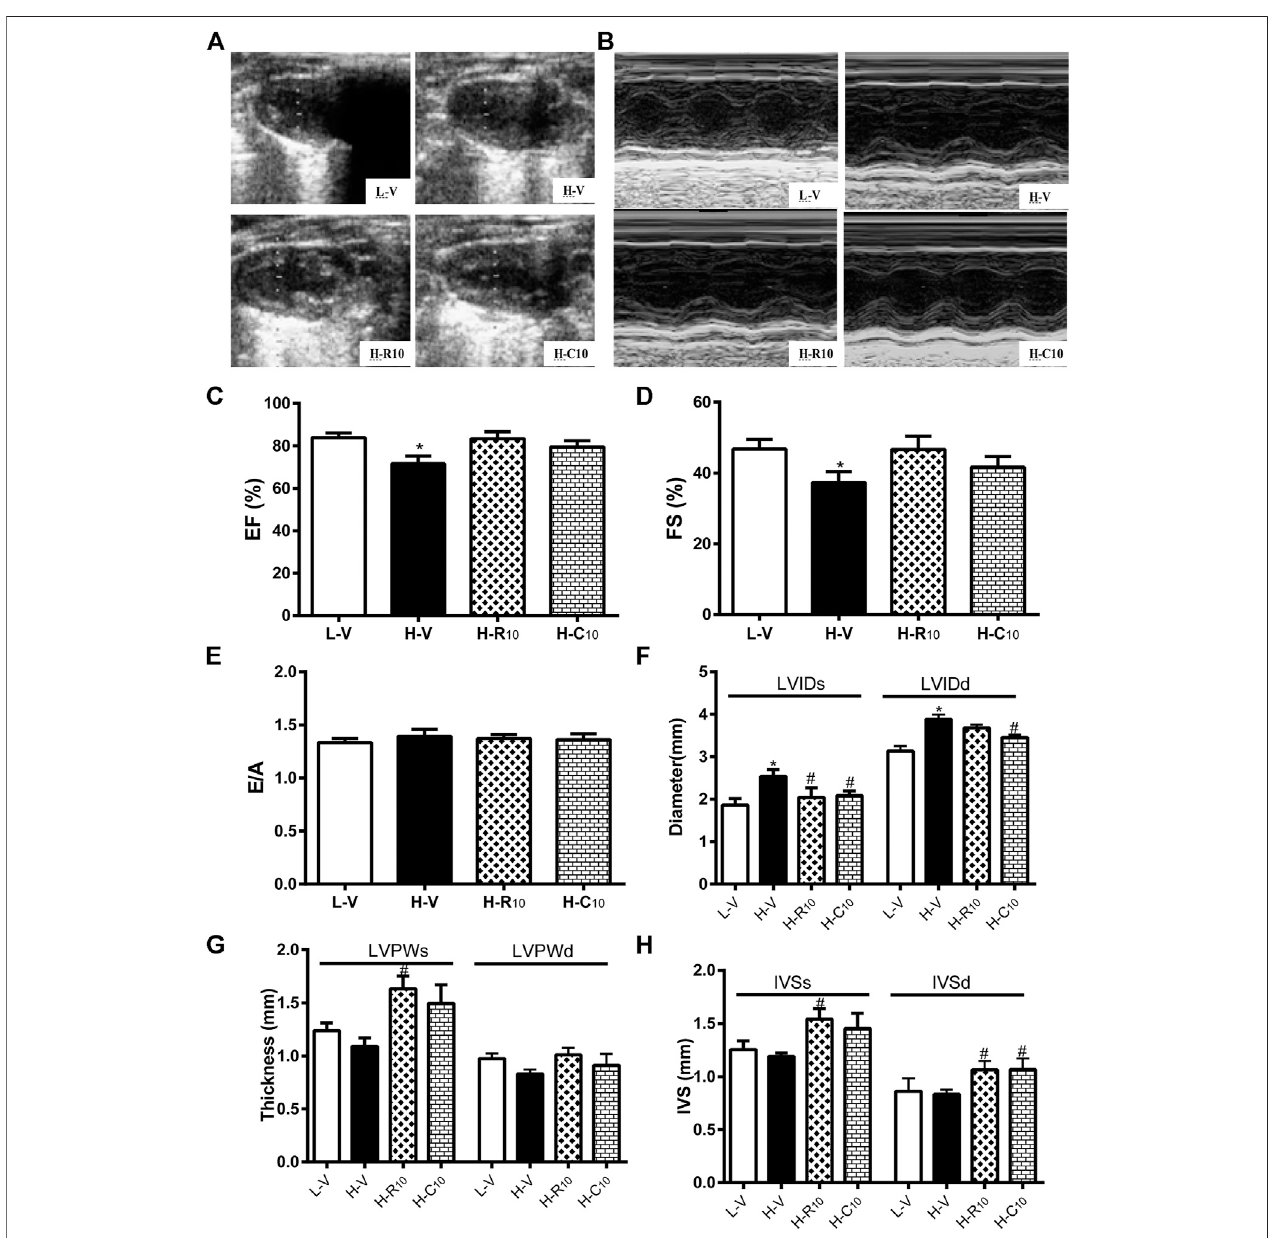
FIGURE 4 | Rosiglitazone and CMHX008 ameliorate HFD-induced myocardial function but have different effects on echocardiographical indexes. (A) Representative 2D echocardiograph and, (B) M-mode image of mice treated with CMHX008, rosiglitazone or vehicle; (C) Quanti fi cation of ejection fraction (EF), (D) fractional shortening (FS), and (E) the ratio of E to A velocity (E/A); (F) Measurements of the left ventricle internal diameters in systole (LVIDs) and diastole (LVIDd), (G) left ventriclewallthicknessinsystole(LVPWs)anddiastole(LVPWd),and (H) theinterventricularseptalthicknessinsystole(IVSs)anddiastole(IVSd).Means ± SEM, n (cid:2) 4 – 6 mice per group, * p < 0.05 vs. L-V, # p < 0.05 vs.